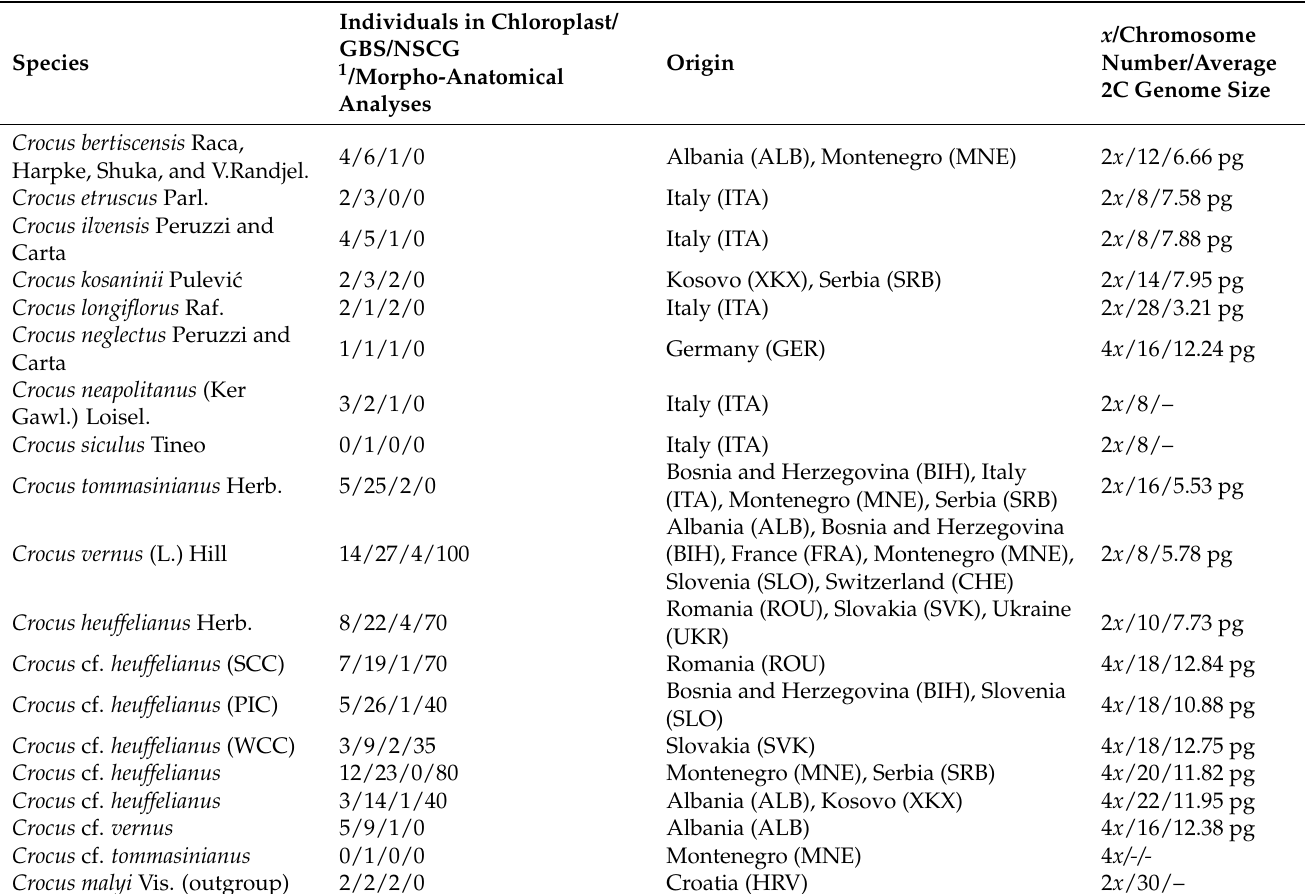
Table 1. Materials from Crocus ser. Verni used in this study (for an extended list see Supplementary Table